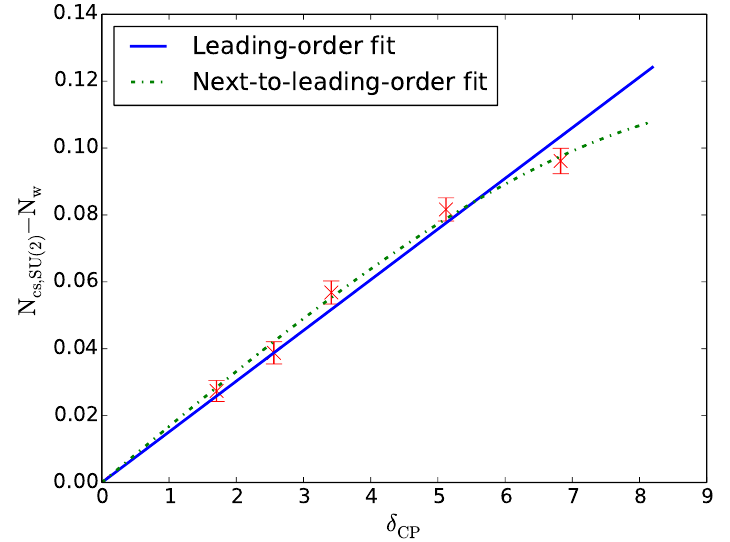
Figure 11 . The di(cid:11)erence between N n = 2 and m H =m =